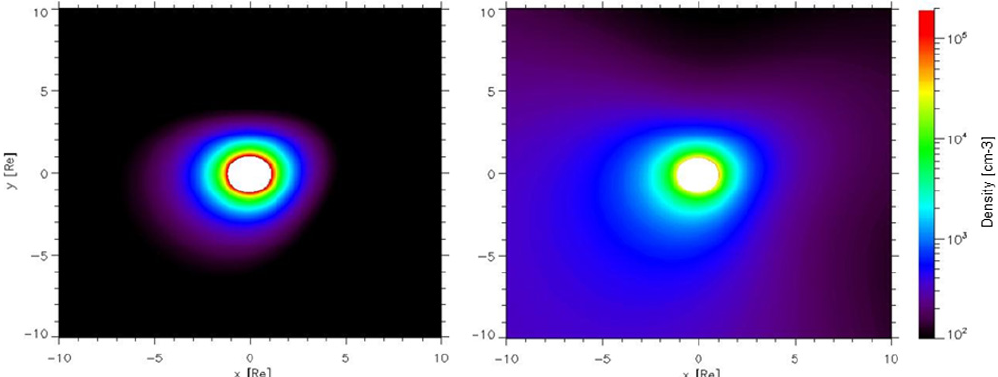
Fig. 7. Exospheric hydrogen density equatorial maps for a solar radio flux of 60S.F.U. and 200S.F.U. (respectively on left and right sides) with the MSIS-86